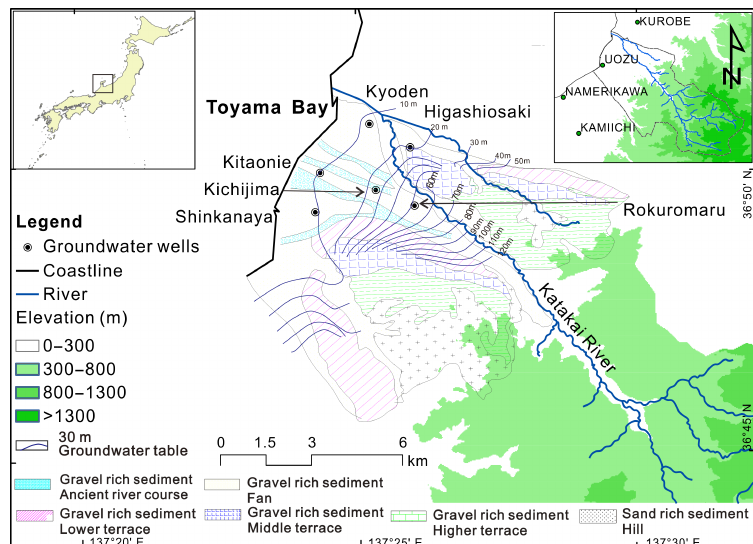
Figure 1. Locations of groundwater wells in the Katakai River alluvial